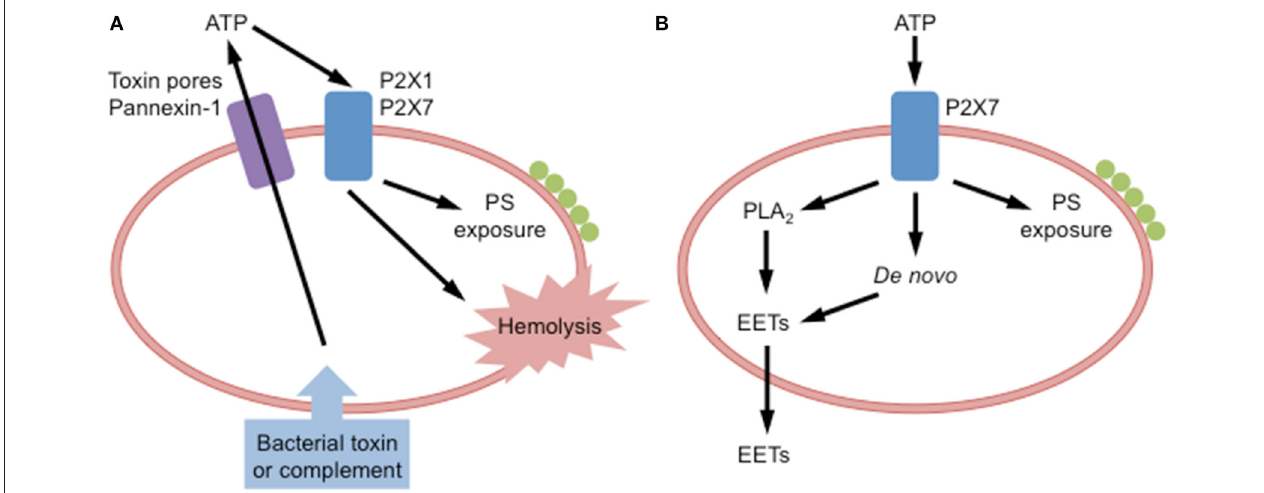
FIGURE 1 | P2X receptor activation in red blood cells. (A) Binding of bacterial toxins or complement to red blood cells causes adenosine triphosphate (ATP) release via toxin pores and pannexin-1. Released ATP can activate P2X1 and P2X7 receptors on these cells to induce phosphatidylserine (PS) exposure and hemolysis. (B) Extracellular ATP can activate P2X7 receptors on red blood cells to induce PS exposure, or formation of epoxyeicosatrienoic acids (EETs), via phospholipase A 2 (PLA 2 ) acting on stored phospholipids or via de novo synthesis, and subsequent EETs release.